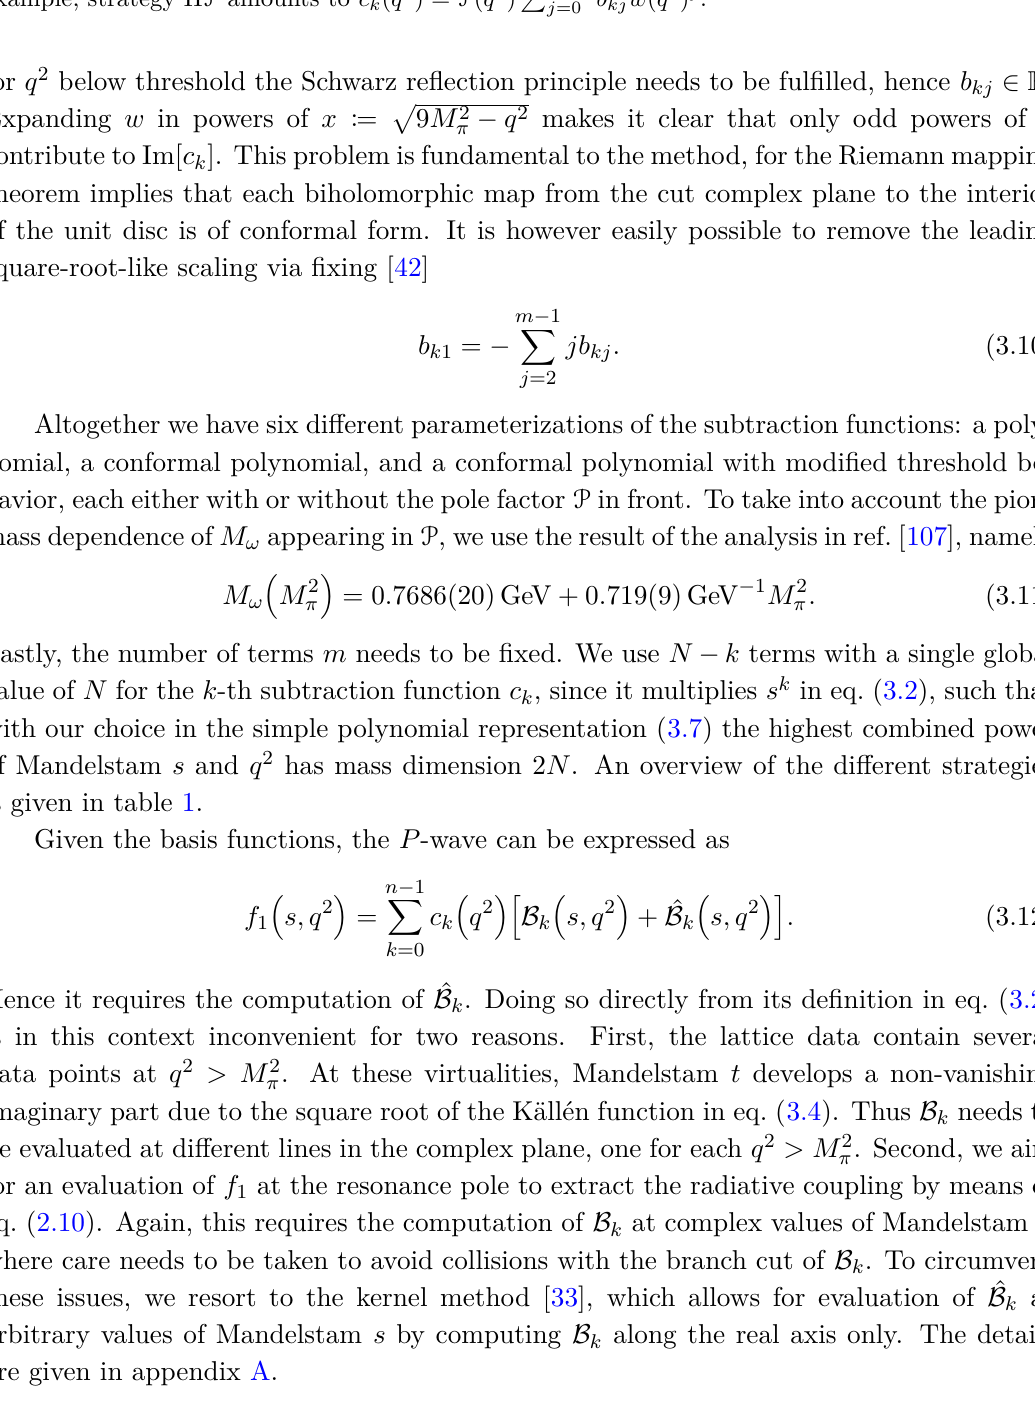
Table 1. The naming scheme of the different parameterizations of the subtraction functions.